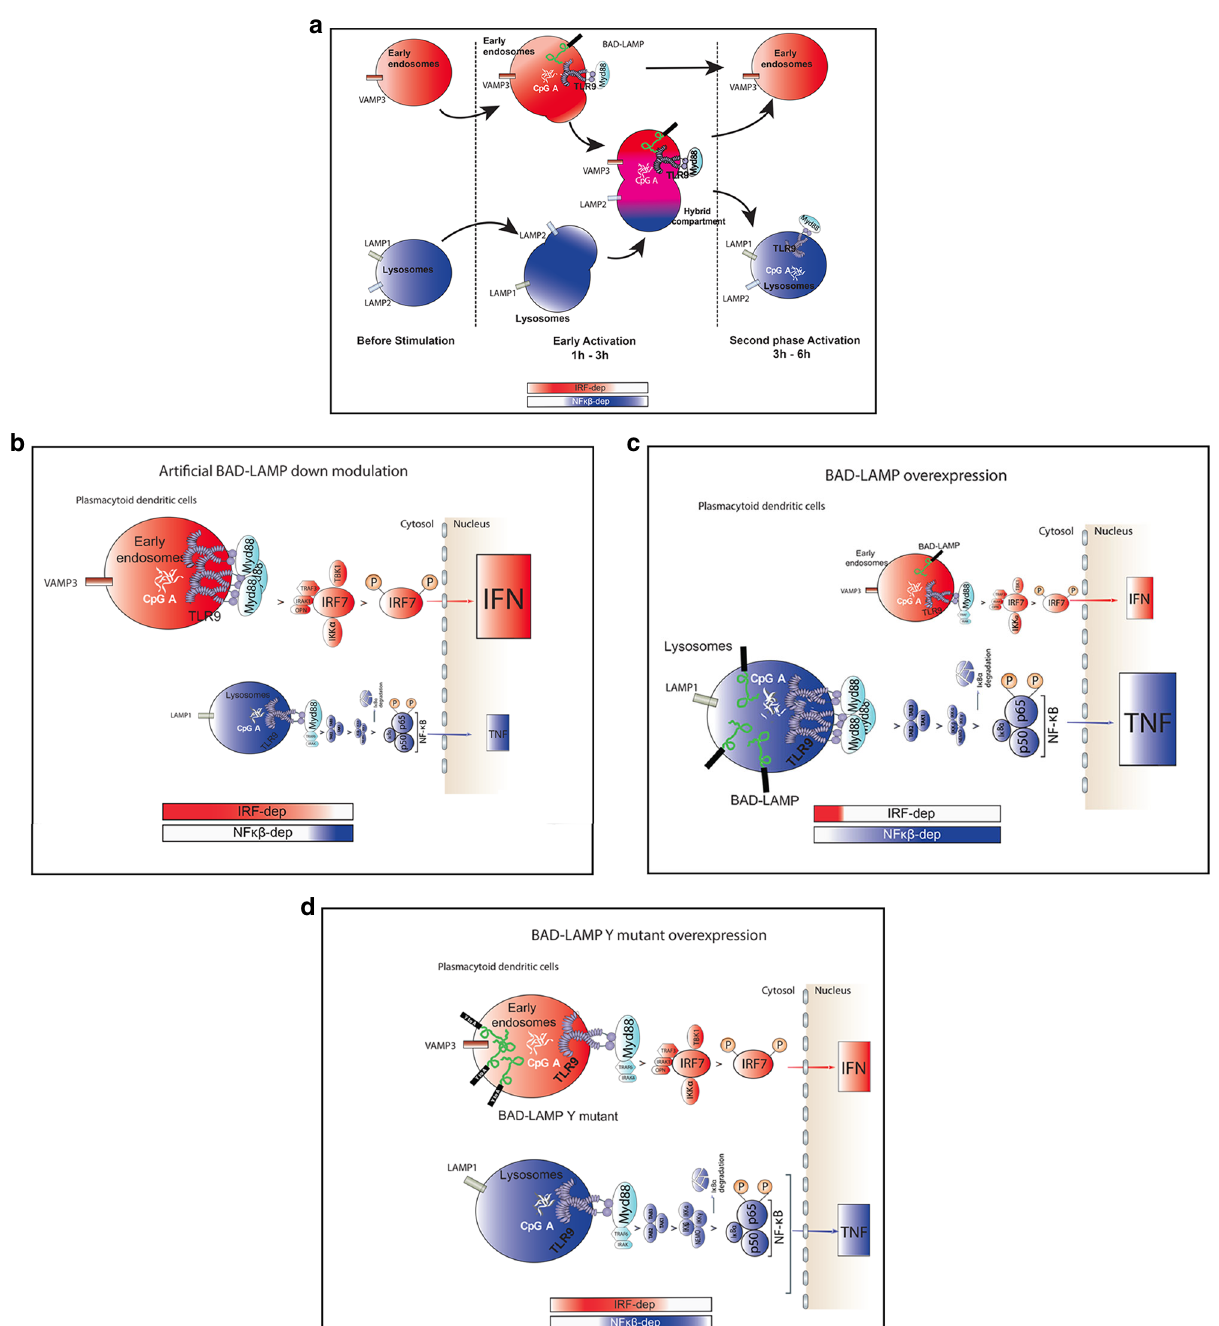
Fig. 5 Graphical abstracts of TLR9 traf fi cking and signalling in human pDCs upon activation or BAD-LAMP manipulation. a Graphical abstract summarizing the results shown in Fig. 4 on the spatiotemporal organisation of endosomes and TLR9 signalling in CpG-activated human pDCs. b Graphical abstract summarizing the results shown in Fig. 6 on the spatiotemporal organisation of endosomes and TLR9 signalling upon BAD-LAMP silencing. c Graphical abstract summarising the results shown in Fig. 7 on the spatiotemporal organisation of endosomes and TLR9 signalling upon overexpression of BAD- LAMP. d Graphical abstract summarising the results shown in Fig. 9 on the spatiotemporal organisation of endosomes and TLR9 signalling, upon overexpression of BAD-LAMP bearing a mutation in its Yxx Φ addressing signal. The bimodal regulation of TLR9 signalling as well as endosomal maturation is represented using rectangles in shading red for IRF7-dependent phase and early endosome and in shading blue for NF- κ B-dependent phase